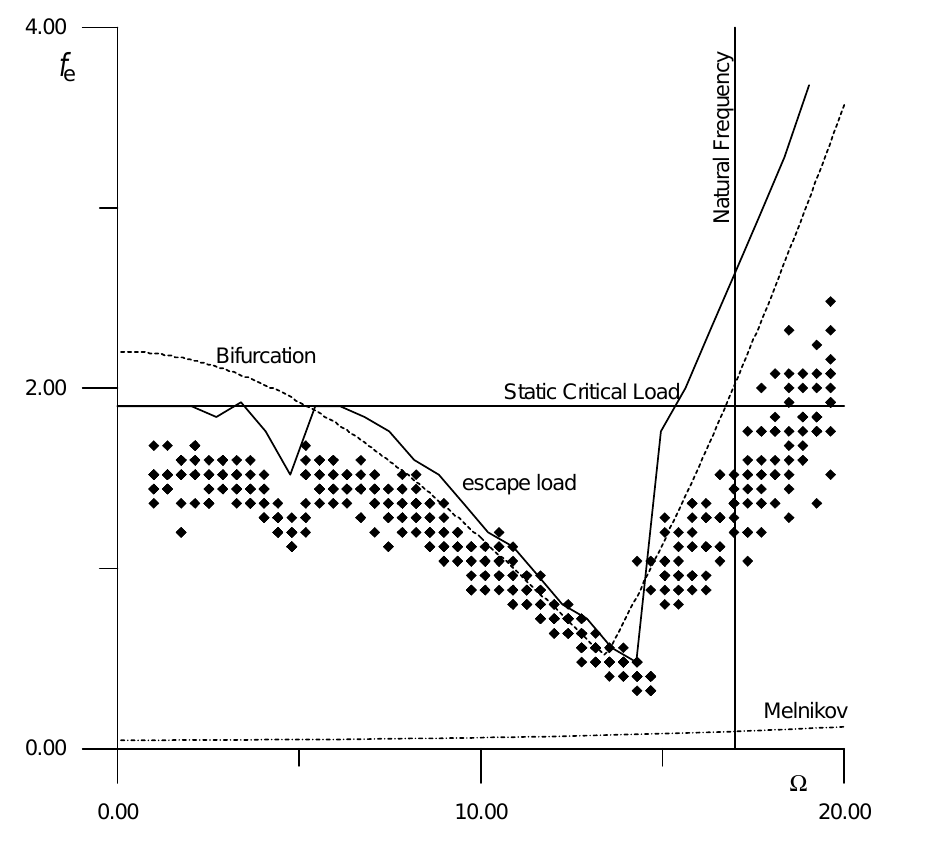
Fig. 5. The escape boundary in force control